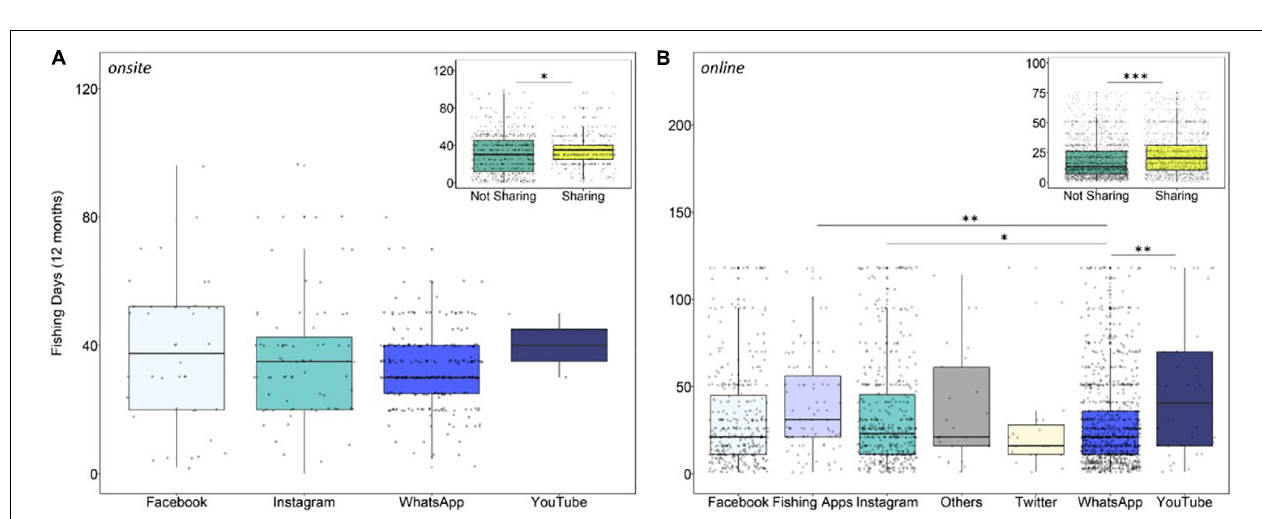
FIGURE 5 | Boxplots of the days spent fishing by recreational fishers during the past 12 months ( A for onsite and B for online surveys; inlets), and by each digital platform used (main plots). In the onsite survey (A) , non-sharers spent, on average, 30 days fishing during the past 12 months, while sharers spent 35 days on average (WhatsApp: N = 255, 30 days; Instagram: N = 75, 35 days; Facebook: N = 40, 38 days; and YouTube: N = 2, 40 days). In the online questionnaire (B) , non-sharers spent an average 13 days fishing during the last 12 months, while sharers averaged 20 days of activity (Twitter: N = 21, 16 days; other platforms: N = 29, 21 days; Facebook: N = 421, 21 days; Instagram: N = 509, 23 days; Fishing Apps: N = 97, 31 days; and YouTube: N = 40, 41 days). Boxplots represent the median (bold centreline), the 25th (top of the box) and 75th percentile (bottom of the box). Significant differences are reported as follow: ∗∗∗ p < 0.001; ∗∗ p < 0.01; ∗ p <